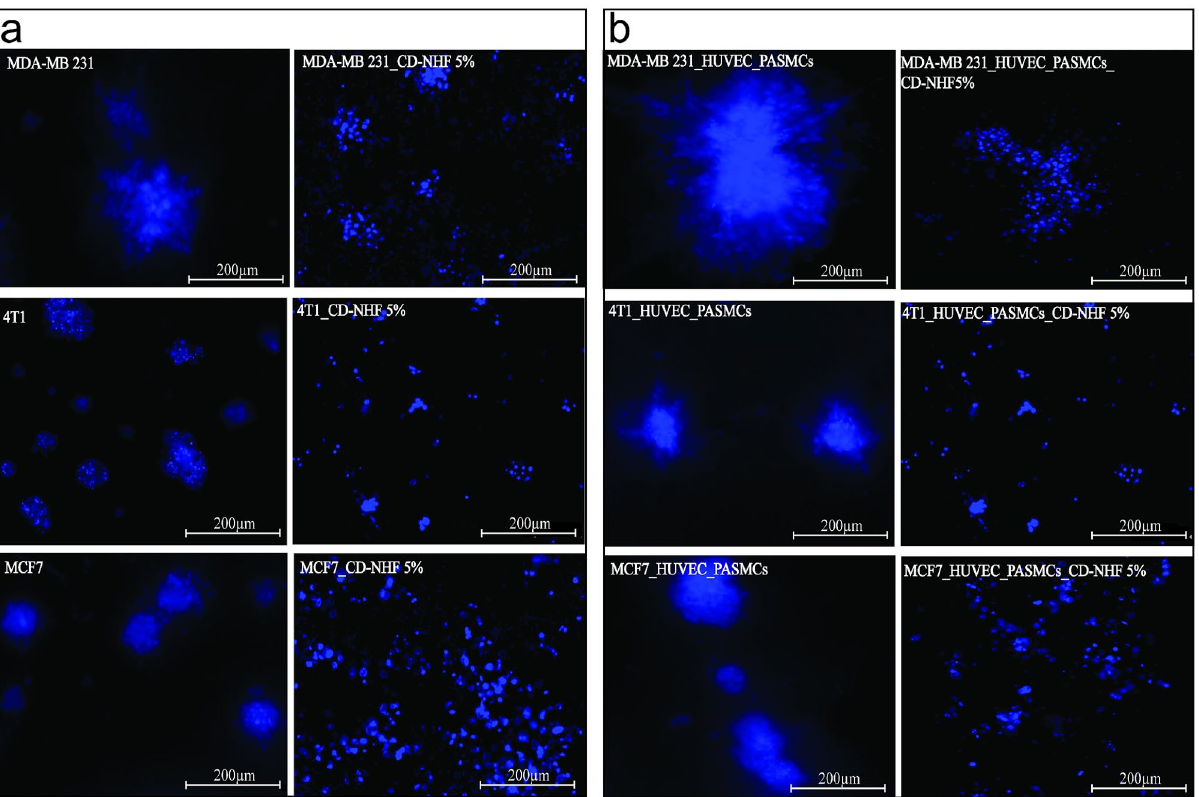
Figure 2. Effect of CD-NHF in 3D matrigel assay. A Monoculture. a,b MDA-MB-231 (a-untreated, b-treated); c,d 4T1 (c-untreated, d-treated); e,f MCF7 (e-untreated, f-treated); B . Co-culture a,b MDA-MB-231 (a-untreated, b-treated); c,d 4T1 (c-untreated, d-treated); e,f MCF7 (e-untreated, f-treated). 10×, N = 3 matrigels/experiment. Pictures acquired at